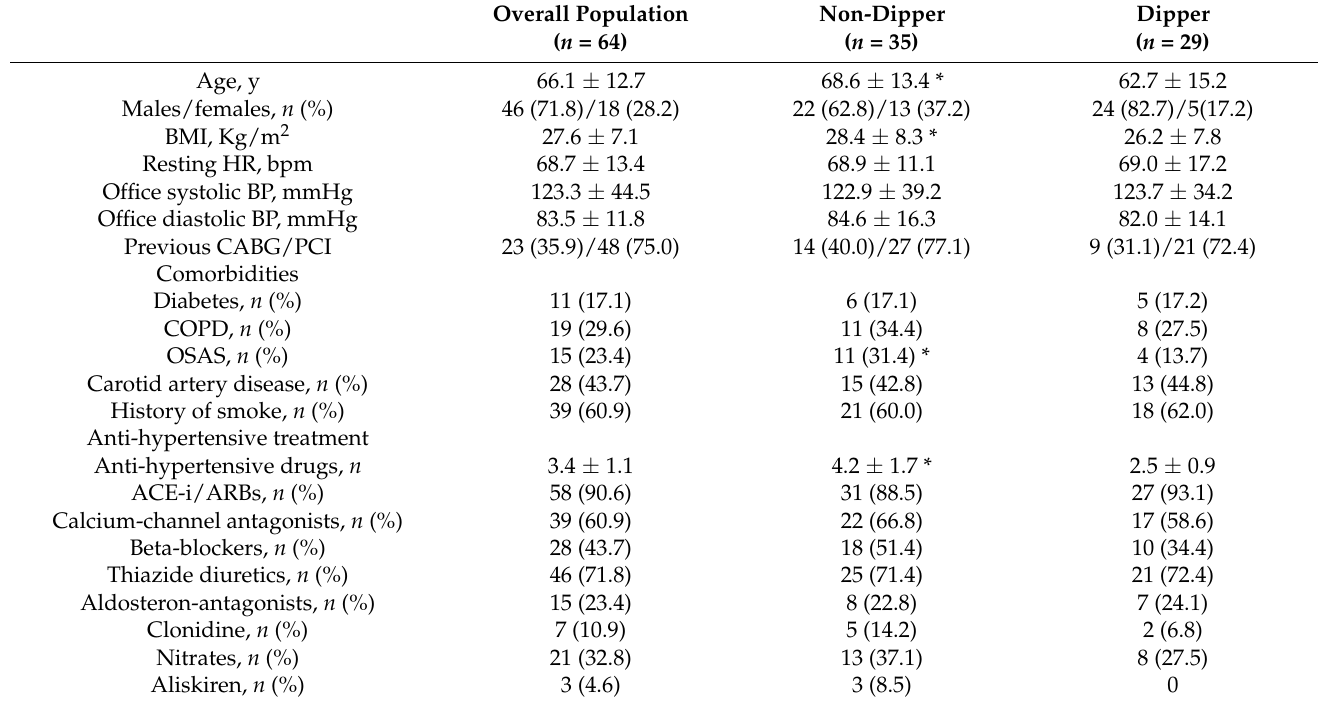
Table 1. Baseline characteristics of the patients who completed the study. Overall Population